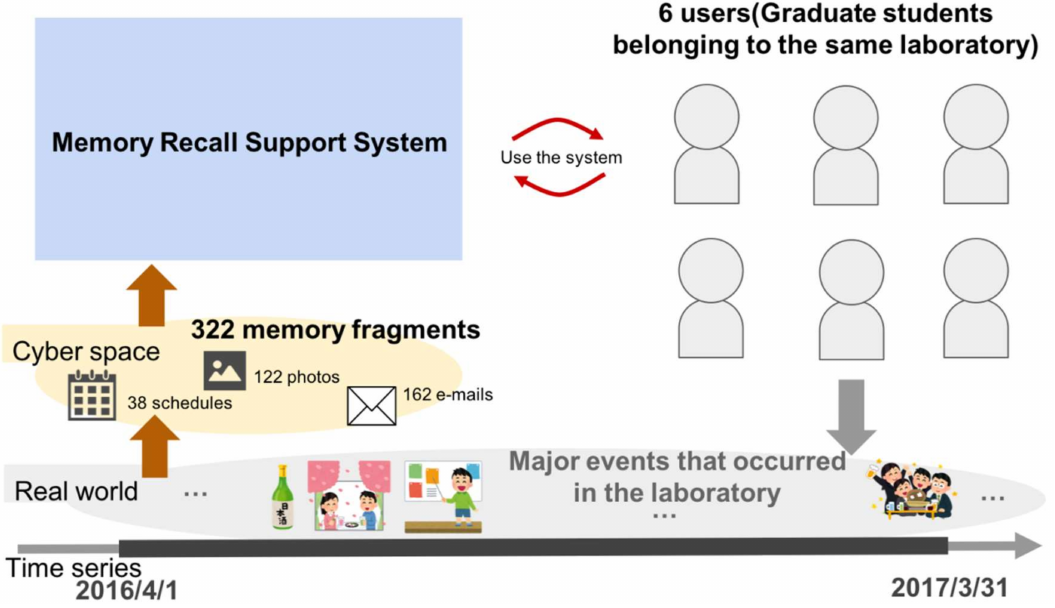
Figure 14. Users and events in experience